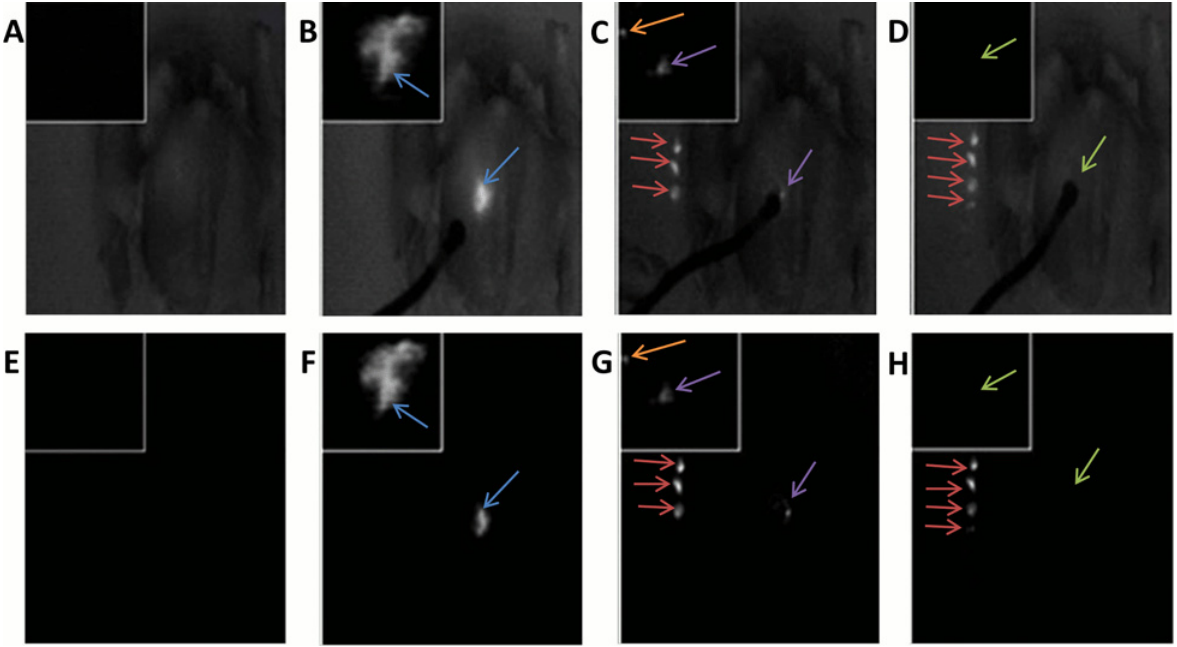
Fig 5. The surgical resection of fluorescent tissues in chicken guided by the Integrated Imaging Goggle with its hand-held microscope. High- resolution microscopic images were incorporated in picture-in-picture mode into the wide FOV stereoscopic goggle frames. Images displayed were illuminated using our light source with unfiltered NIR components for anatomical data (A-D) and using only the low pass filtered light (E-H). The images are from four distinct time points during the resection of the fluorescent tissue: (A & E) Chicken pre-injection; (B & F) post-injection and prior to any resection; (C & G) after a partial resection (excised tissue indicated by red arrows), note the residual lesions in both the goggle and microscope images (purple arrows); orange arrows indicate small residual lesions that are only revealed by the microscopic imaging; and (D & H) after complete resection and removal of residual fluorescent tissues (green